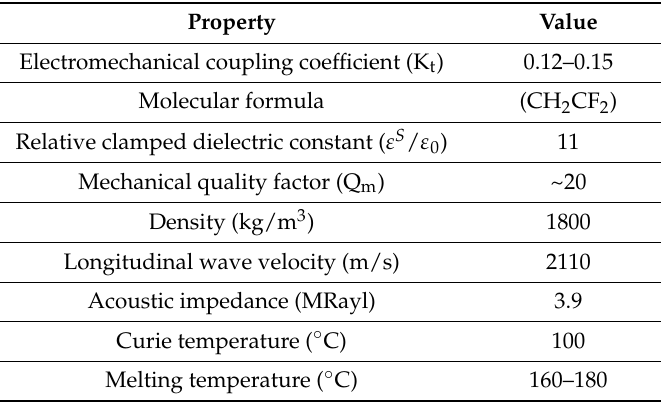
Table 1. Typical properties of PVDF 1